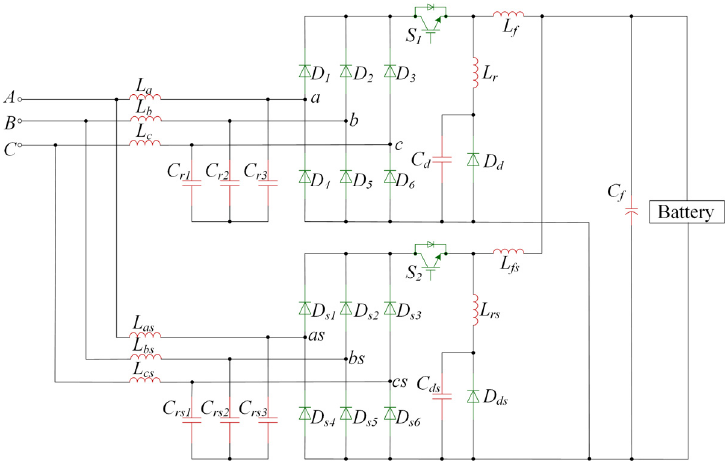
Figure 4. The proposed OBC.